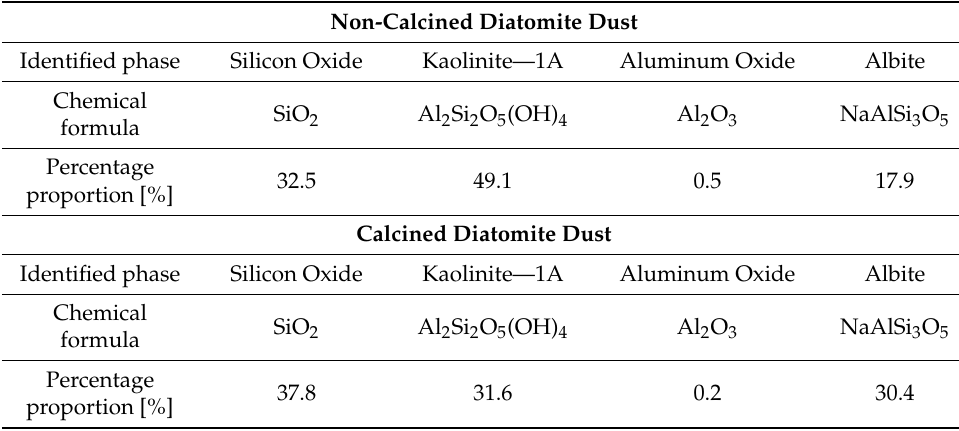
Table 4. Phase composition of non-calcined and calcined diatomite dust.